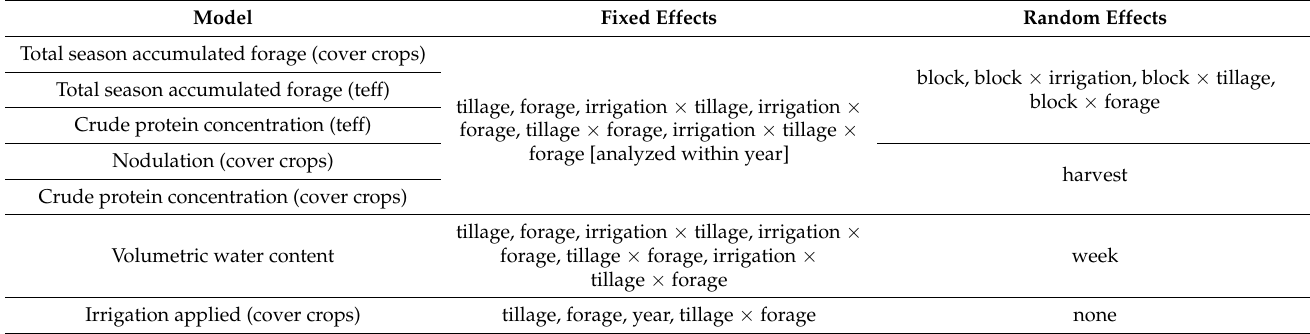
Table 3. Summary of main effects tested for each statistical